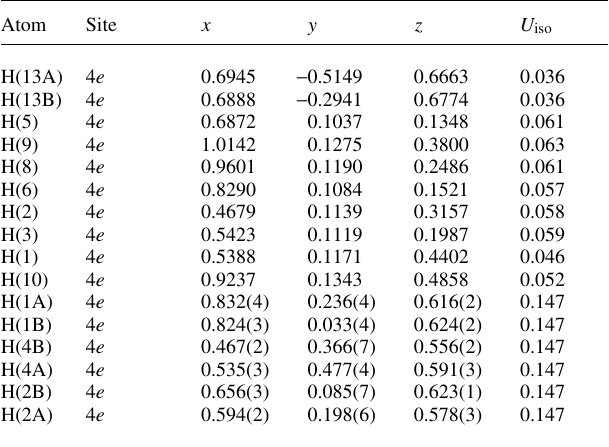
Table 2. Atomic coordinates and displacement parameters (in Å 2 )